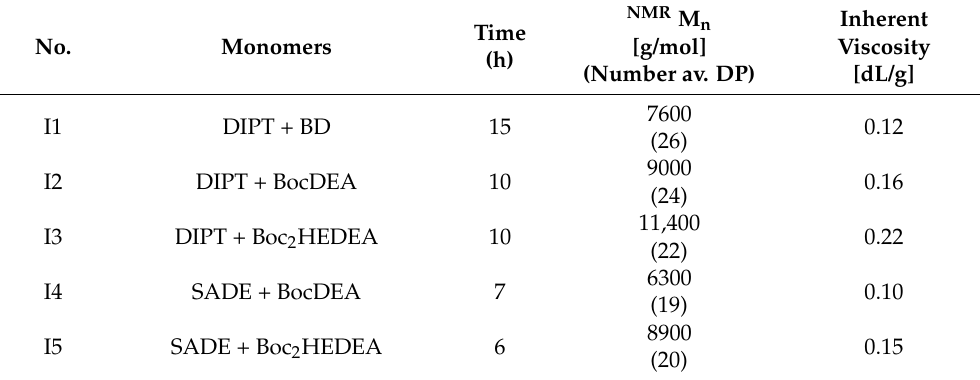
Table 1. Properties of polymers obtained by a polytransesterification